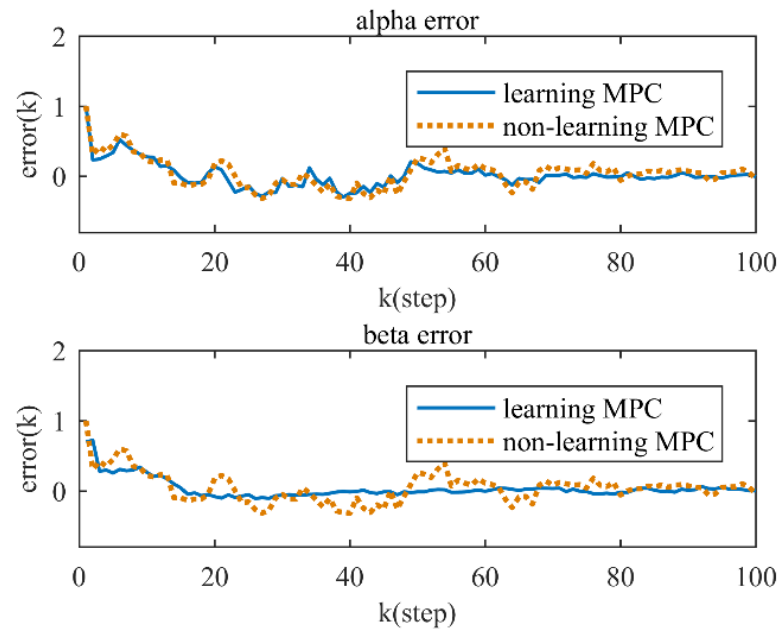
Figure 7. Estimated error of parameters α ( k ) and β ( k ) .